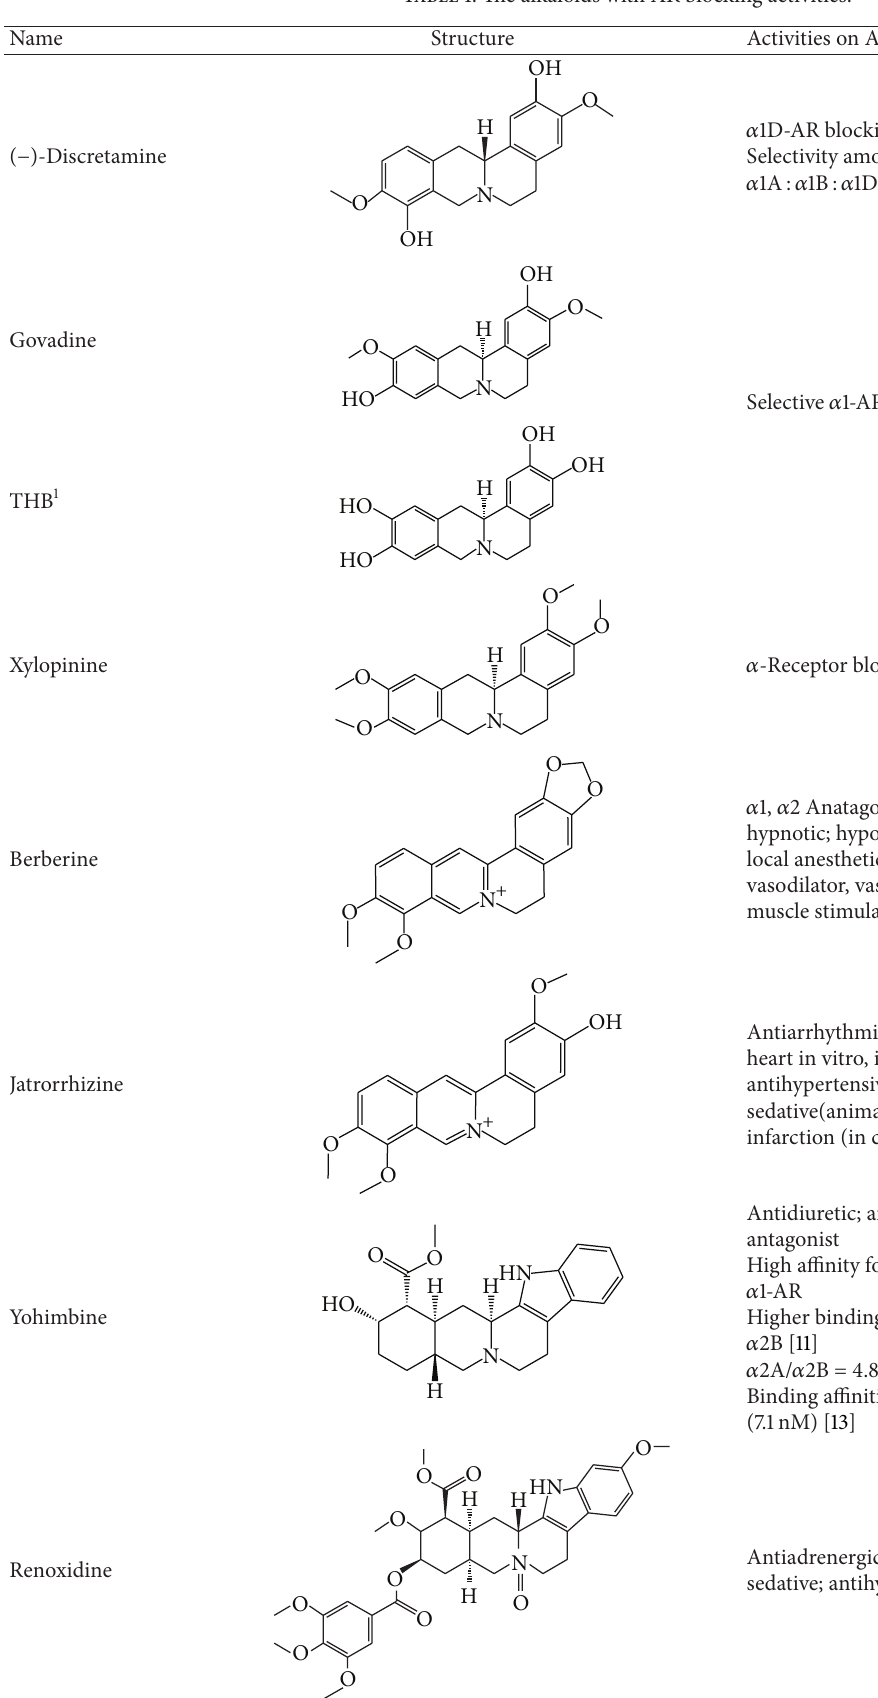
Table 1: The alkaloids with AR blocking